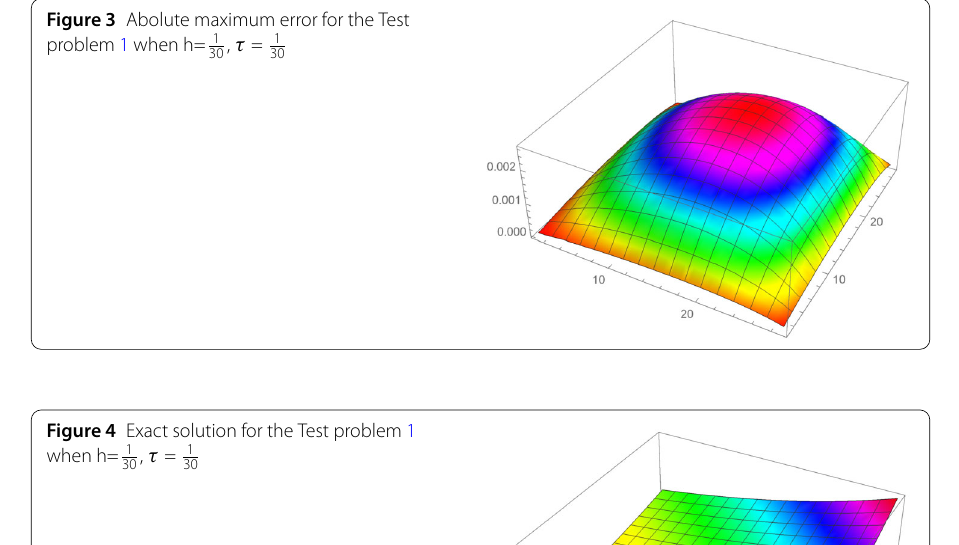
Figure 3 Abolute maximum error for the Test problem 1 when h= 1